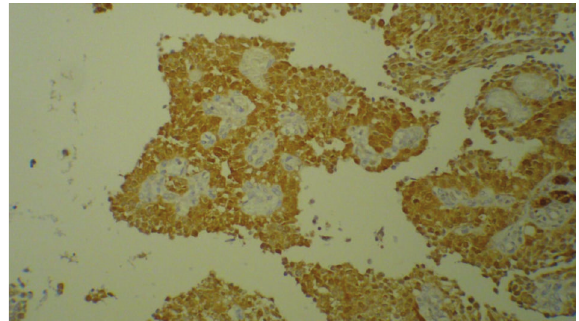
Figure 3: Immunohistochemical labeling of tumor cells with calre-